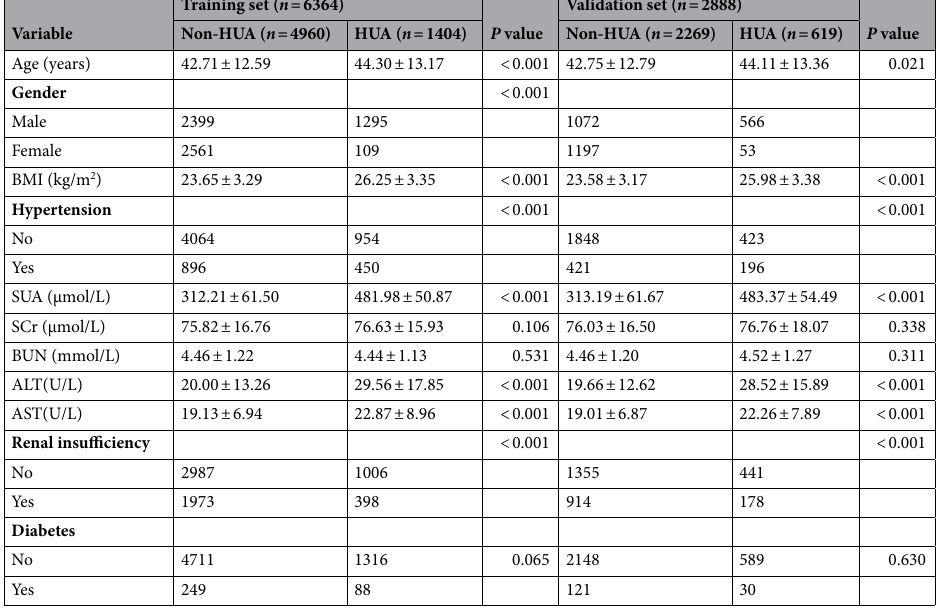
Table 1. Clinical characteristics of the population used in this